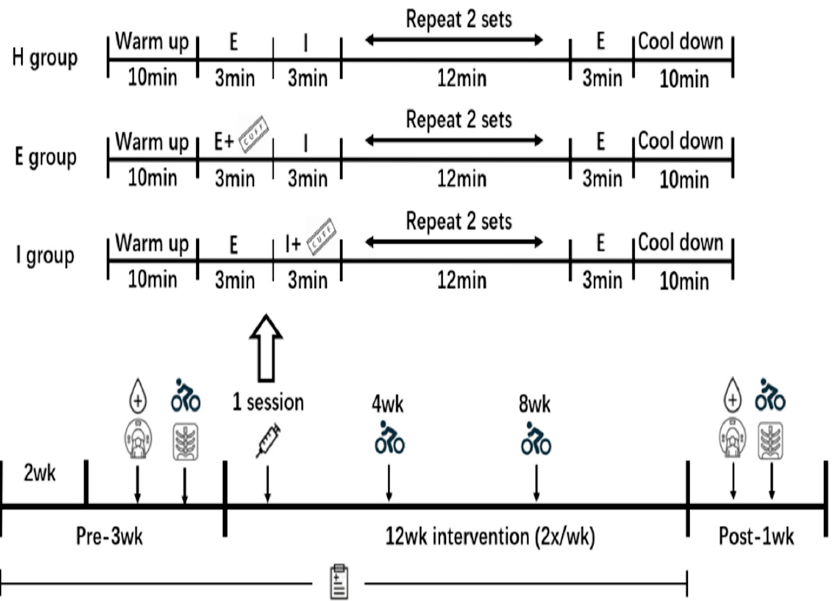
Figure 2. Experimental design and exercise program. Note: = phase of blood flow restriction; = fasting blood collection in the morning; = dual-energy X-ray test; = maximum oxygen uptake test; = computed tomography test; = blood collection before and after acute exercise.